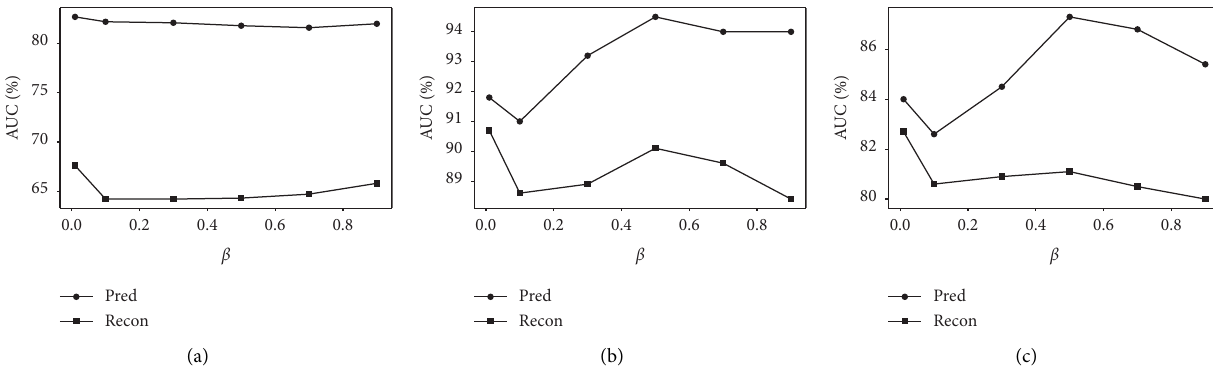
Figure 6: Prediction and reconstruction model results with diferent β values ( β � 0.01, 0.1, 0.3, 0.5, 0.7, and 0.9). (a) Ped1 dataset. (b) Ped2 dataset. (c) Avenue dataset.